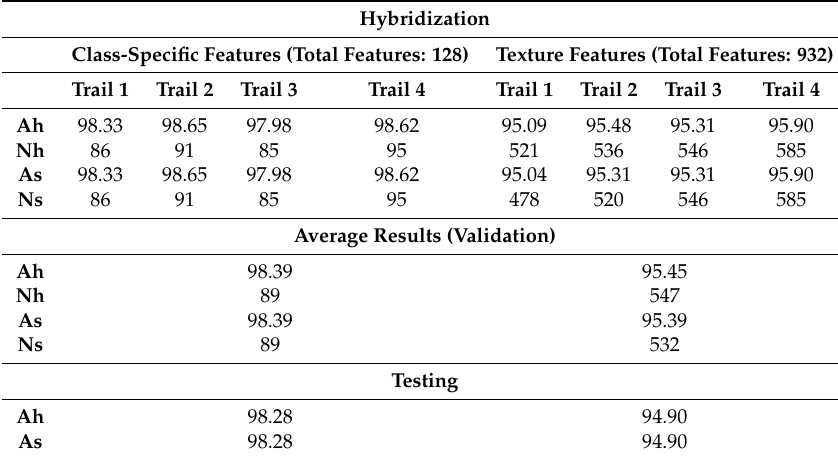
Table 3. Hybridization results: Experimental protocol 1.